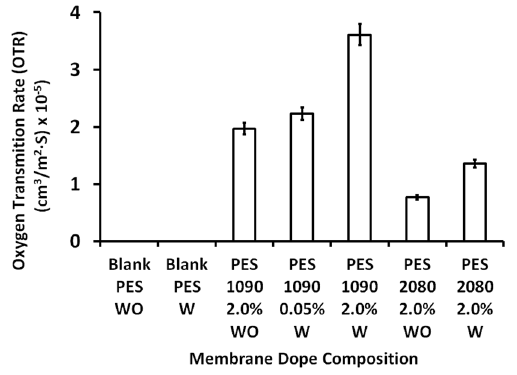
Figure 16. Oxygen Transmission Rate (OTR) of the bank PES and the magnetic mixed matrix PES membranes without and with using 0.1 wt% of Lithium chloride additive in the membrane